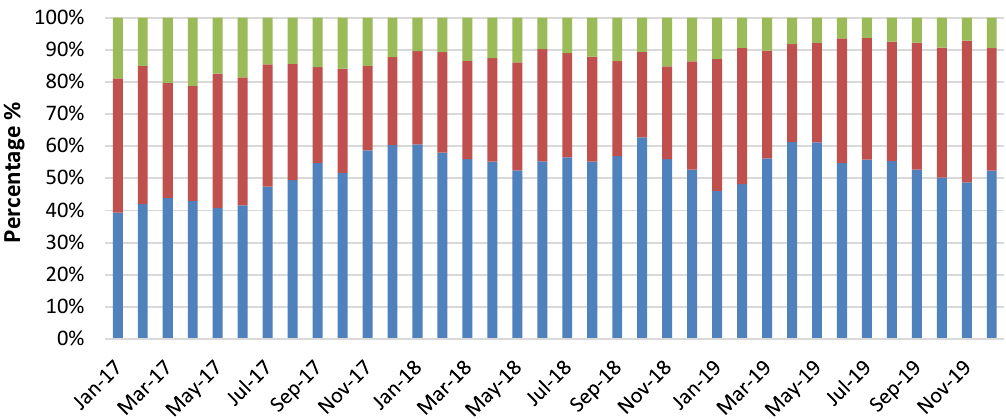
Figure 8. The percentage share of particular co-substrates in the feedstock supplied digester in the Iława WWTP.